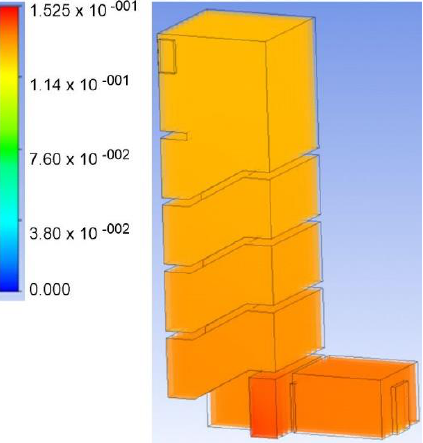
Figure 7. Carbon dioxide distribution for a closed building. Carbon dioxide was measured as a mass fraction.